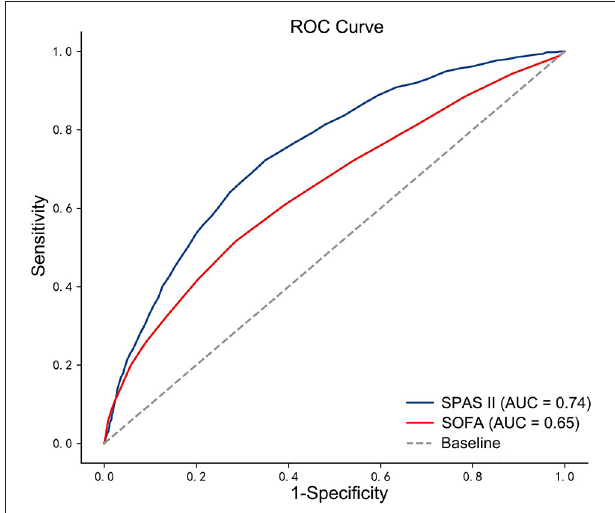
FIGURE 2 | The ROC curves for SOFA score and SAPS II score with 1-year postoperative mortality. ROC, receiver-operating characteristic.